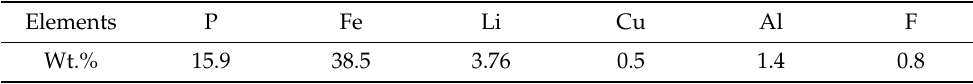
Table 1. Chemical composition of the spent LiFePO 4 cathode powder.